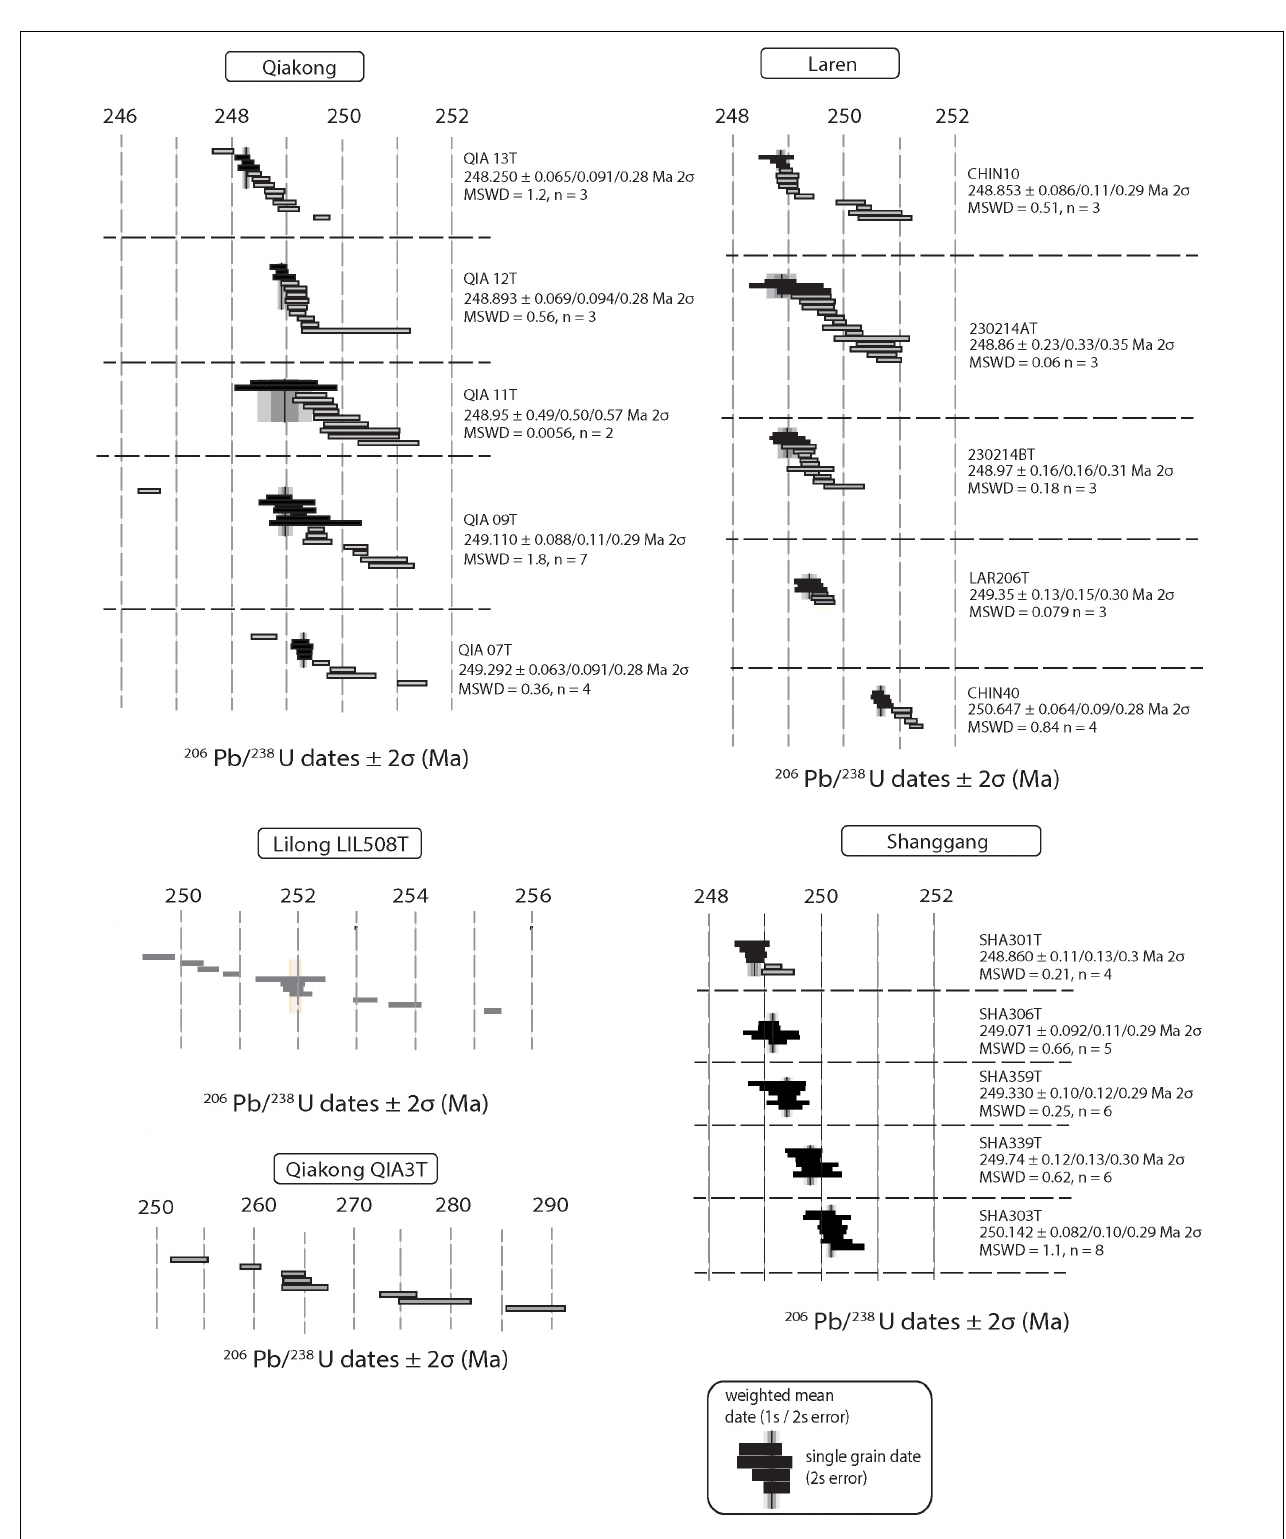
FIGURE 3 | 206 Pb/ 238 U single-grain zircon analyses of volcanic ash layers from sections Qiakong, Laren Shanggang, and Lilong. MSWD = mean square of weighted deviates. Horizontal bars: single-grain zircon analysis (2 σ error). Weighted mean ages are calculated from grains marked in black, analyses marked in gray are excluded from the weighted mean age calculation. Vertical bar: weighted mean age and 2 σ error ( x = internal, y = external uncertainty including tracer calibration, z = external uncertainty including tracer calibration, and 238 U decay constant uncertainty).